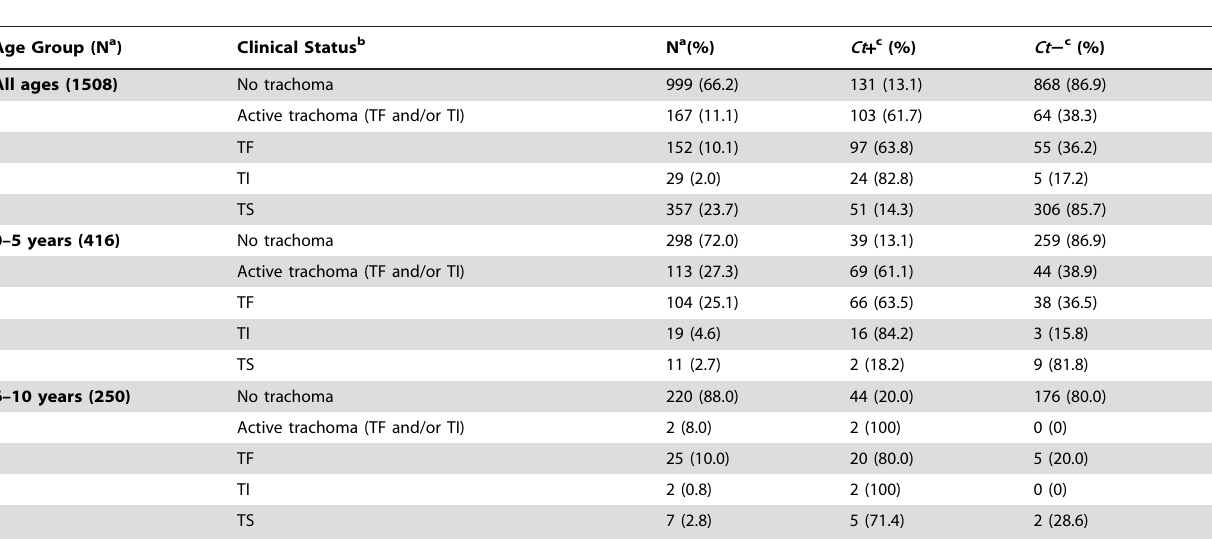
Table 2. The relationship between trachoma and presence of infection with C. trachomatis ( Ct ).